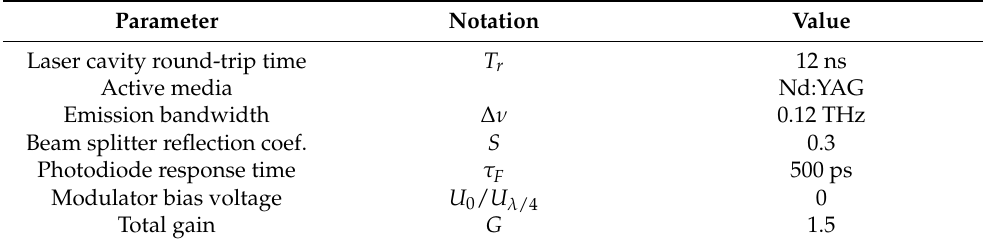
Table 3. Numerical simulation parameters.